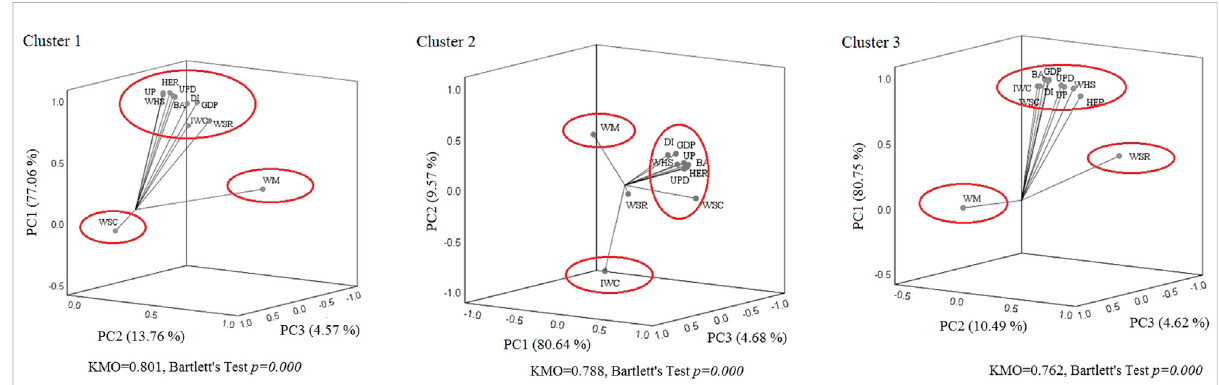
FIGURE 7 Affecting factors of liters per capita per day in clusters 1, 2, and 3. UP, urban population; UPD, urban population density; HER, ratio of high education received; GDP, gross domesticproduct; DI,disposableincome of households; BA, built-up area; WSC, water supply capacity; WSR, water saving and reuse rate; IWC, investment in water conservation; WM, the number of front-loading washing machines; WHS, the number of water heaters for